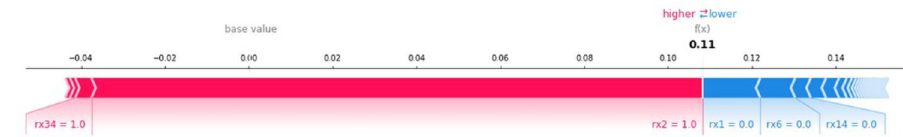
Fig 2. Local interpretation of RF model prediction for ADR-related hospital admissions for fake observation. Decodes for the number of each medicine class are provided in Table 4.